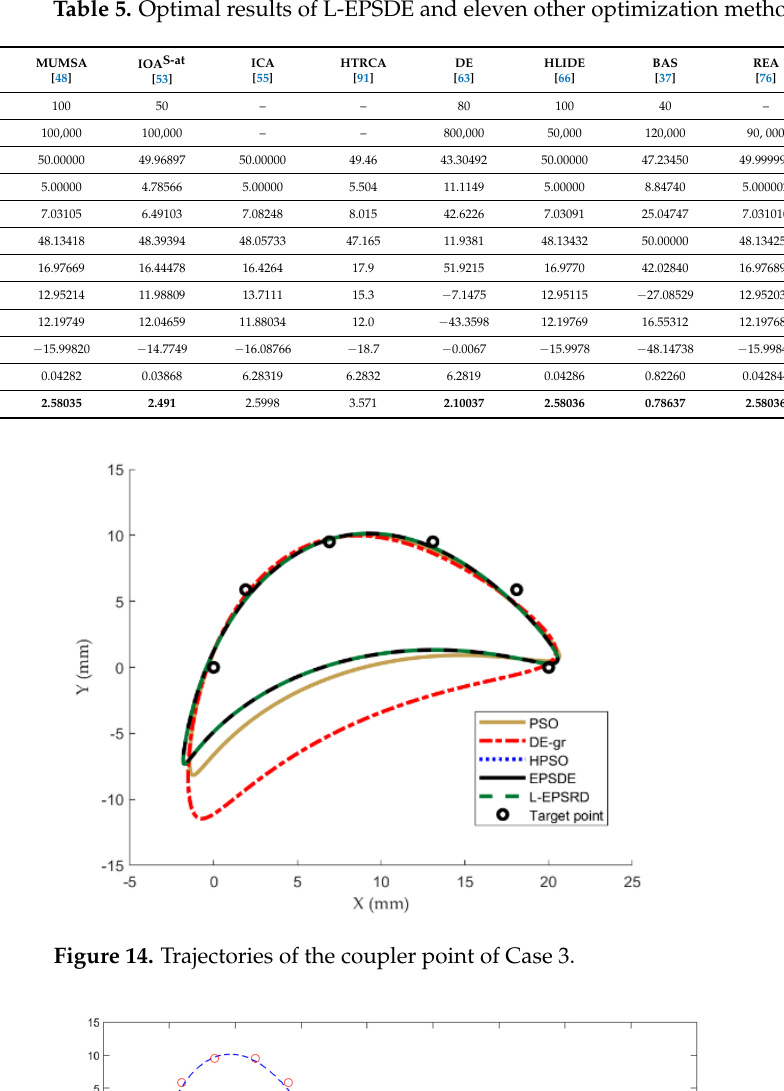
Figure 15. Trajectory of the coupler point of Case 3.